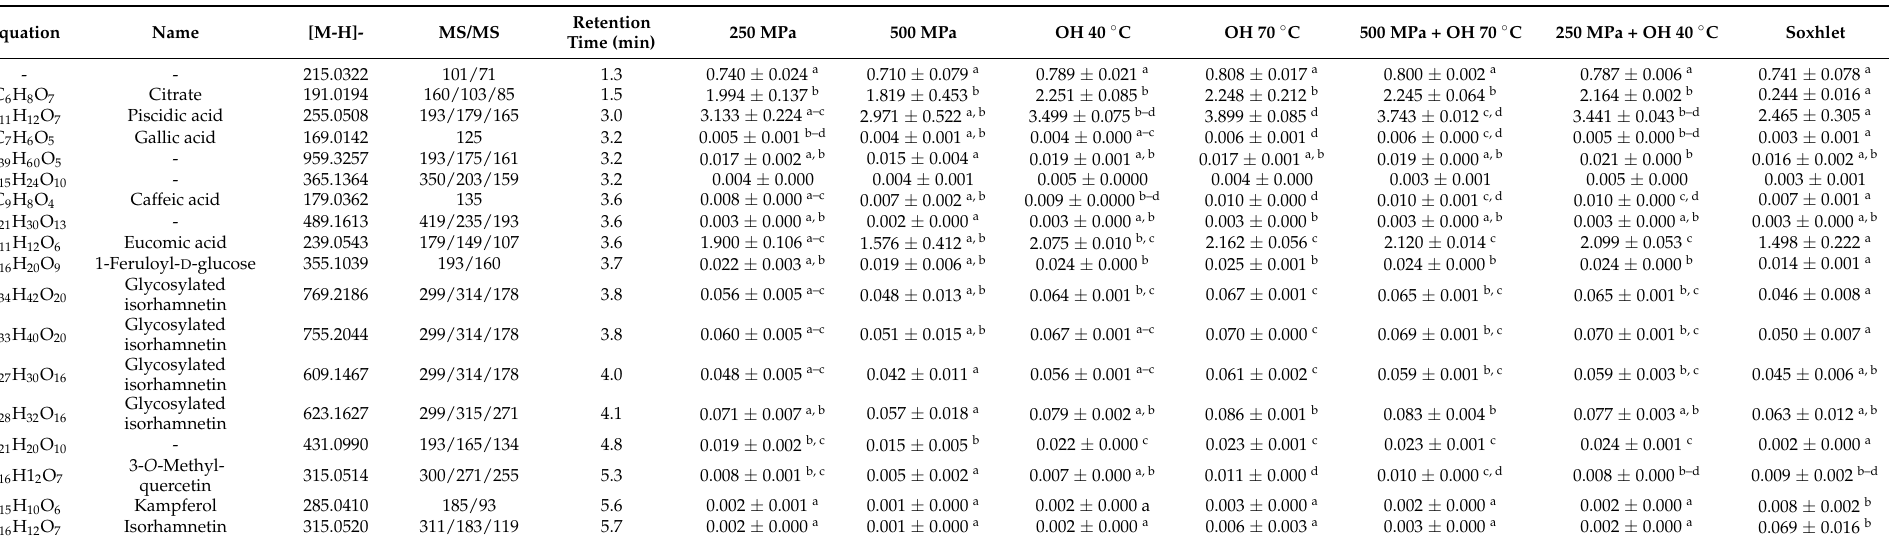
Table 2. Individual phenolic compounds of selected extracts obtained using an ethanol concentration of 30% (mg/g